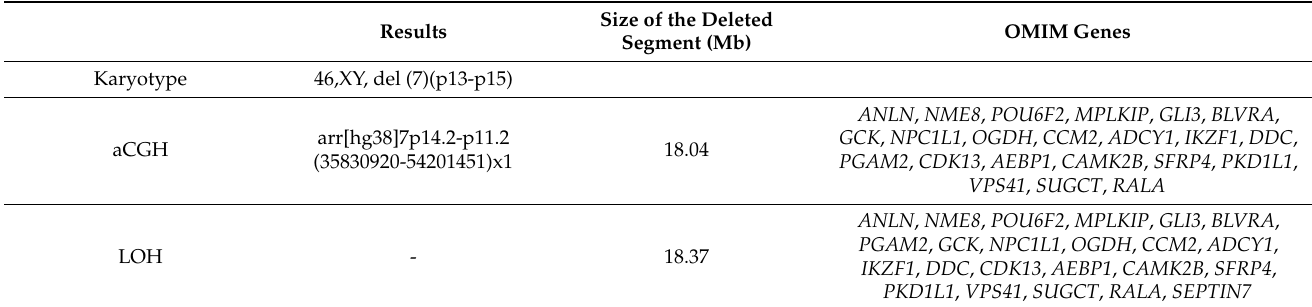
Table 1. Results of the cytogenetic- and the molecular cytogenetic investigations.